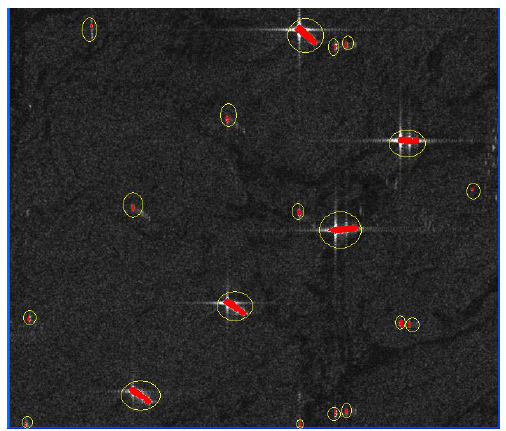
Figure 4. manually-produced reference